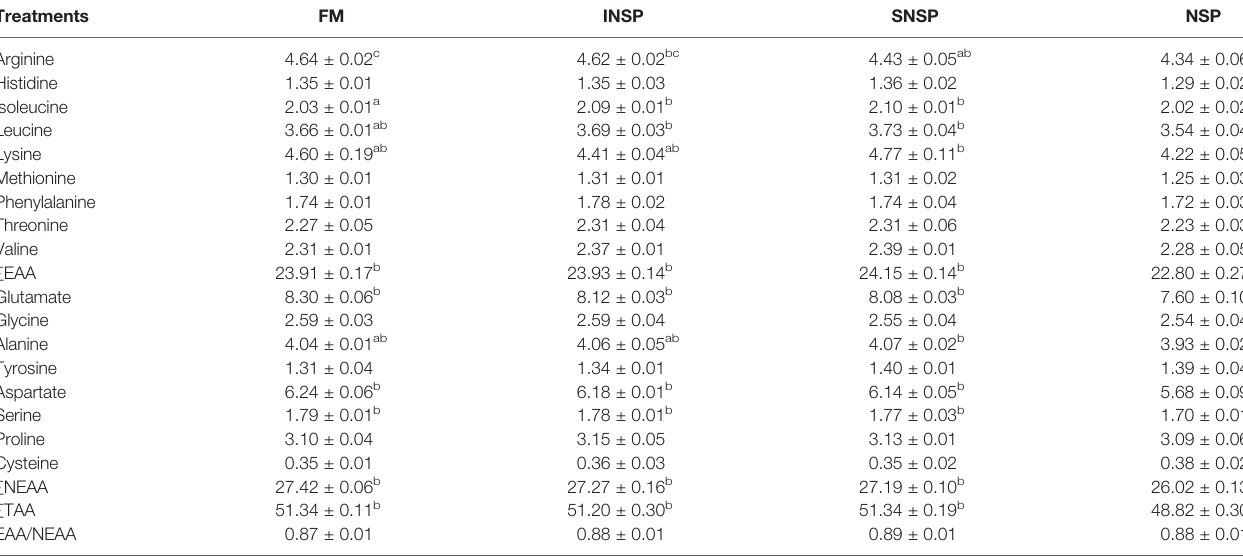
TABLE 8 | Amino acids pro fi les (% dry matter) in the whole-body of GIFT tilapia fed diets with different types of non-starch polysaccharides. Treatments